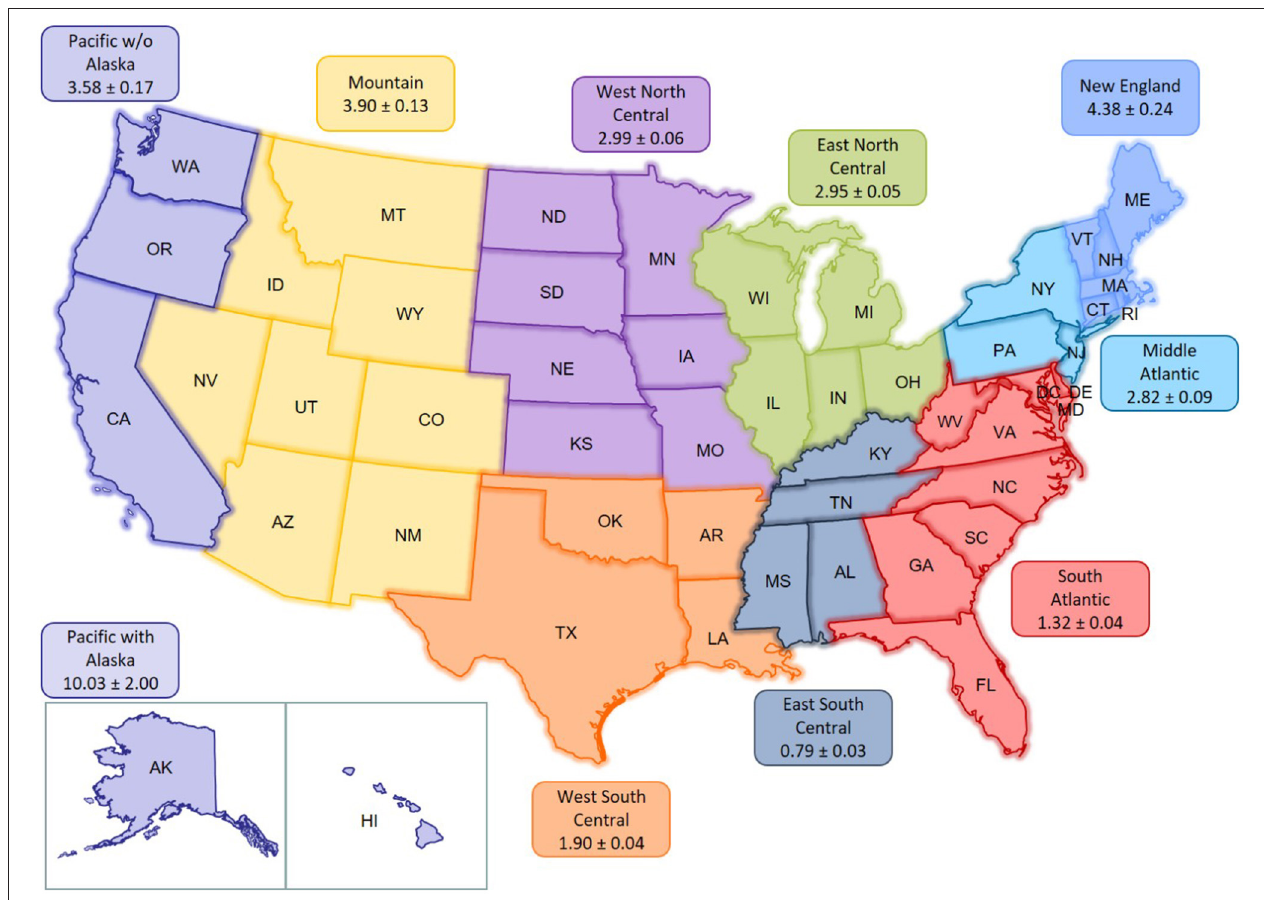
FIGURE 2 | Regionalized CRSI results with estimate of uncertainty.